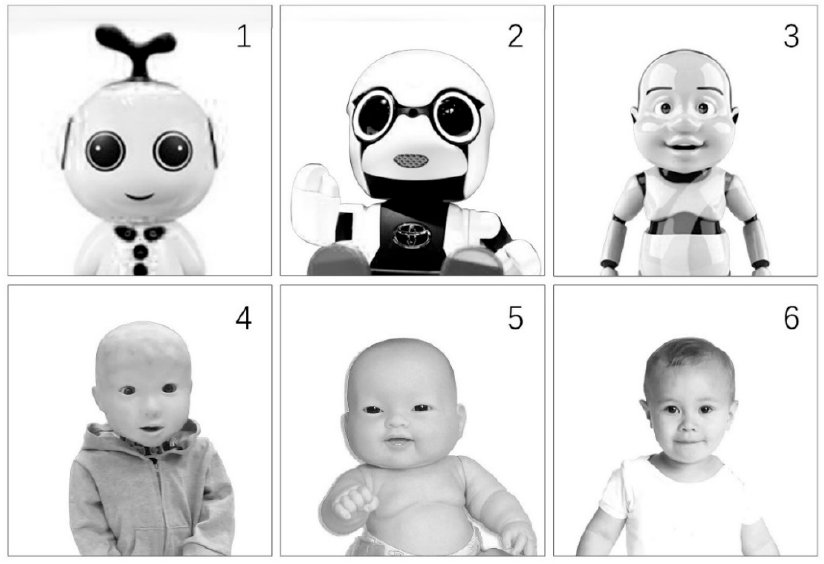
Figure 2. The baby robot stimuli utilized in this study.